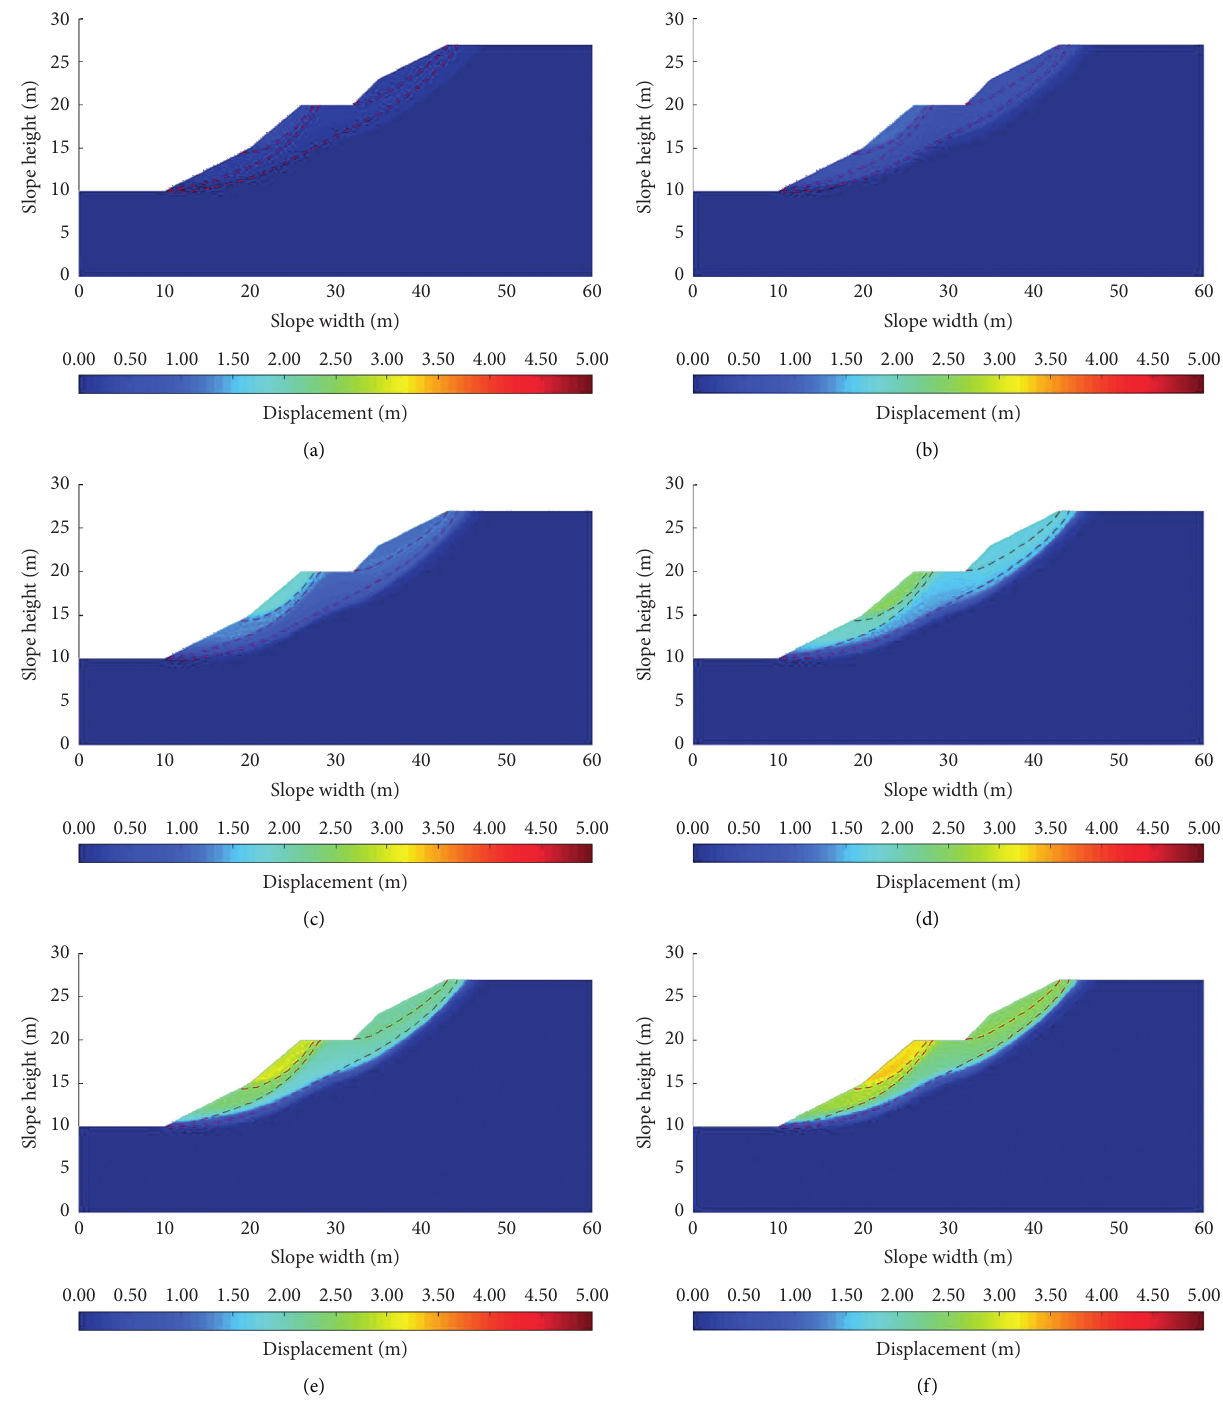
Figure 8: Comparison of multiple failure slip surfaces between SPH (at different times) and LEM [10]: (a) t � 1s; (b) t � 2 s; (c) t � 3s; (d) t � 4 s; (e) t � 5 s; (f) t � 6